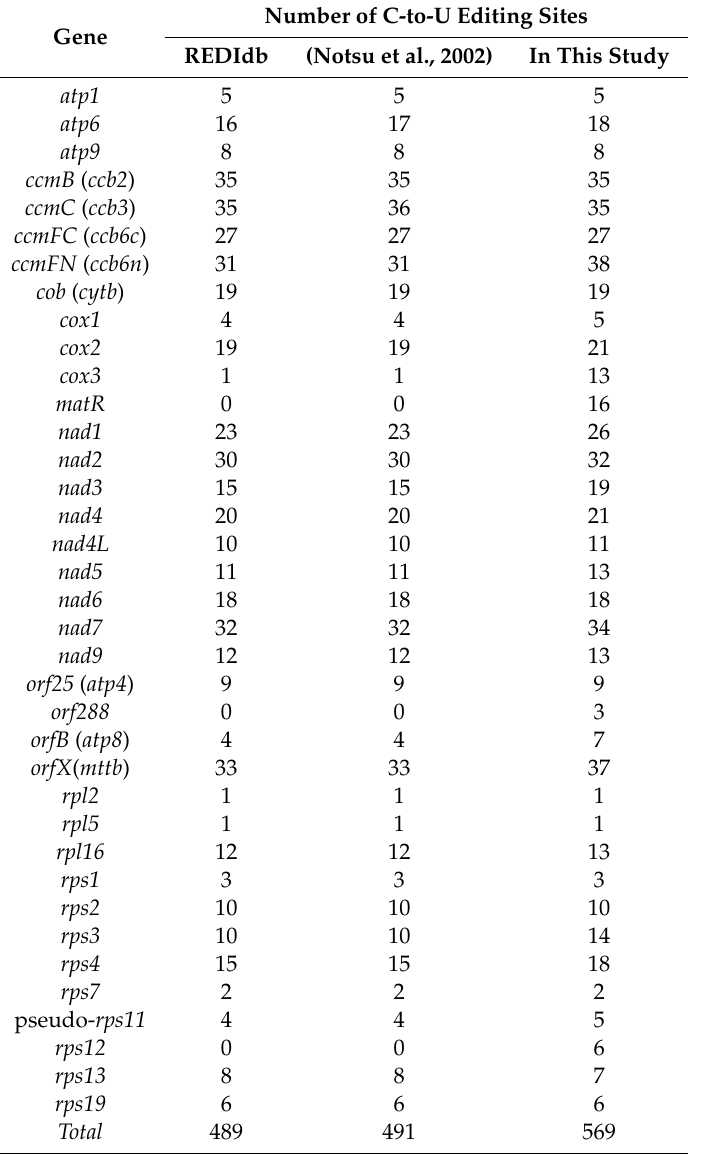
Table 1. Number of editing sites in rice mitochondria-encoded open reading frames (ORFs) reported by di ff erent